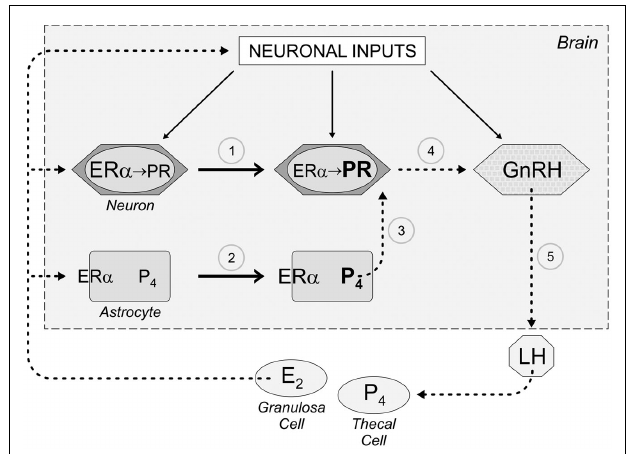
FIGURE 2 | Schematic diagram describing the role of astrocytes, which we propose mediate estrogen positive feedback of the LH surge. As follicles develop in the ovary, granulosa cells under the influence of follicle stimulating hormone (FSH) begin producing estradiol (E 2 ).While this level of E 2 is inhibitory to the neural network regulating the release of GnRH (negative feedback), this E 2 induces the expression of progesterone receptors in hypothalamic neurons (1) through activation of nuclear estrogen receptor- α (ER α ).When circulating levels of E 2 peak on proestrus (estrogen positive feedback), E 2 now binds to ER α on the membrane of astrocytes that transactivates metabotropic glutamate receptor 1a (mGluR1a) increasing cytoplasmic calcium by releasing intracellular calcium stores (positive feedback), which stimulate the synthesis of progesterone (P 4 ; 2).This de novo synthesized P 4 diffuses from the astrocyte to bind E 2 -induced PR in nearby neurons (3).We suspect that these neurons use kisspeptin as a transmitter and activate GnRH neurons (4) causing the surge release of GnRH (5) that stimulates LH release form pituitary gonadotropes.The LH then induces ovulation and luteinization of the follicle in which theca lutein cells synthesize P 4